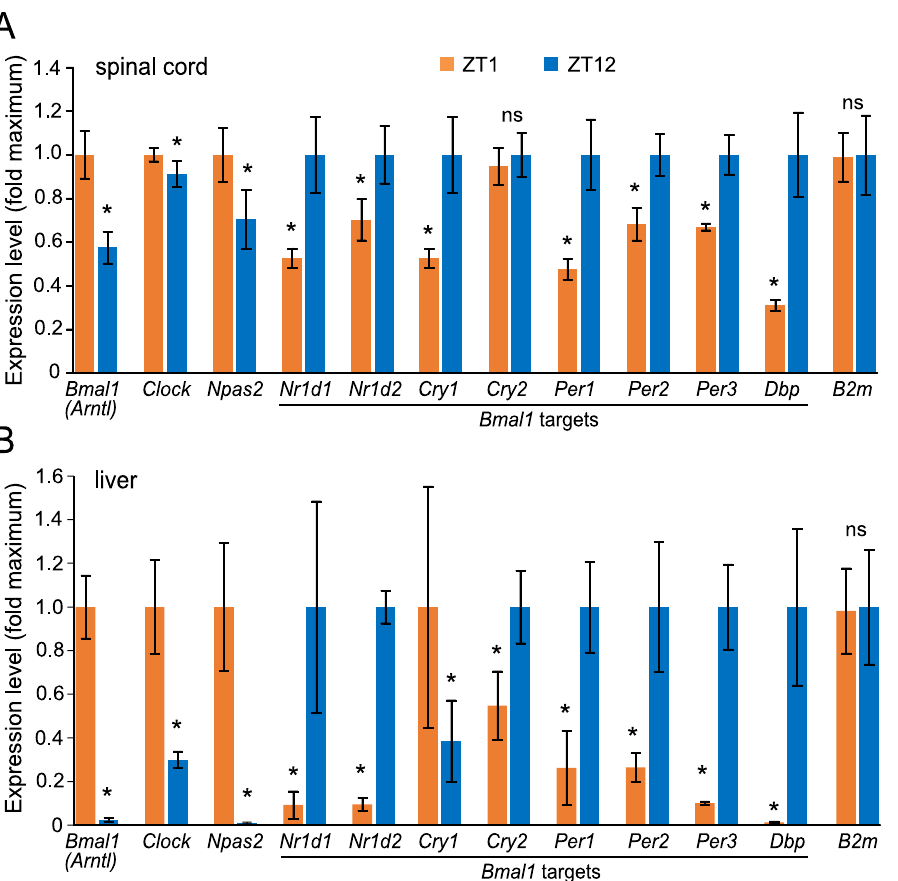
Fig 1. Time of day effects on expression of clock pathway mRNAs in the intact mouse spinal cord. Levels of mRNAs were determined at ZT1 and ZT12 by qPCR using total RNA from the lower thoracic segment of the spinal cord (A) and the liver (B). Gapdh was used as a normalizer for expression level determinations, B2m was also included as an additional normalizing transcript. Note that lower levels of Bmal1 expression at ZT12 coincide with increased levels of several BMAL1 target genes suggesting increased activity of the clock pathway output. The observed differences in the spinal cord are consistent with reported maximal amplitudes of clock pathways mRNA in other non- SCN regions of mouse brain at the beginning and the end of the active period (S1 and S2 Figs). For each transcript, data represent average fold change of a time point with maximal expression ± SD; � , p < 0.05, ns > 0.05, U test; n = 3 mice/time